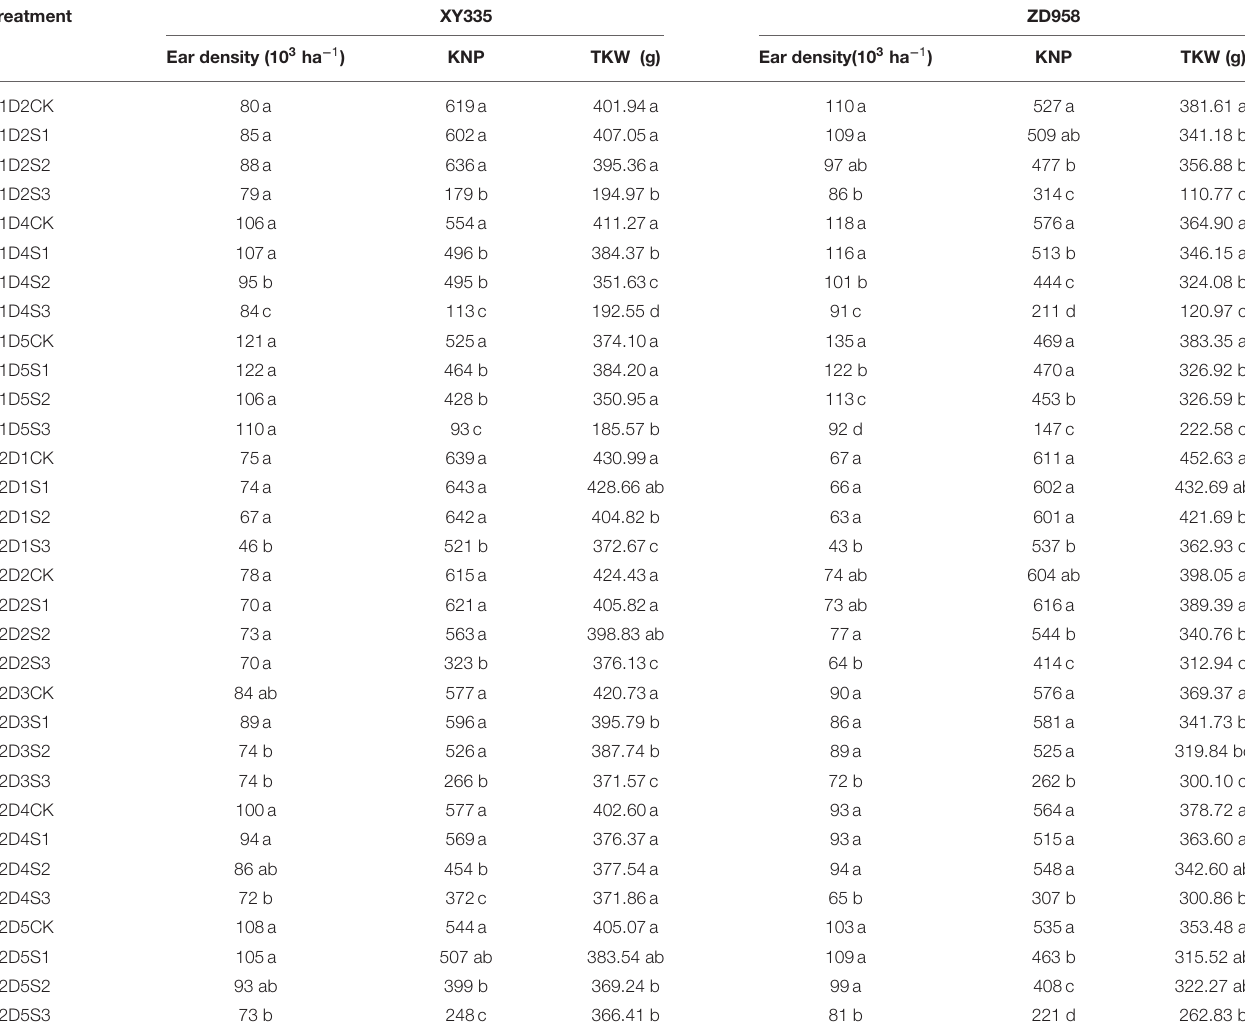
TABLE 2 | Yield components of maize under different shading levels and planting densities. Treatment